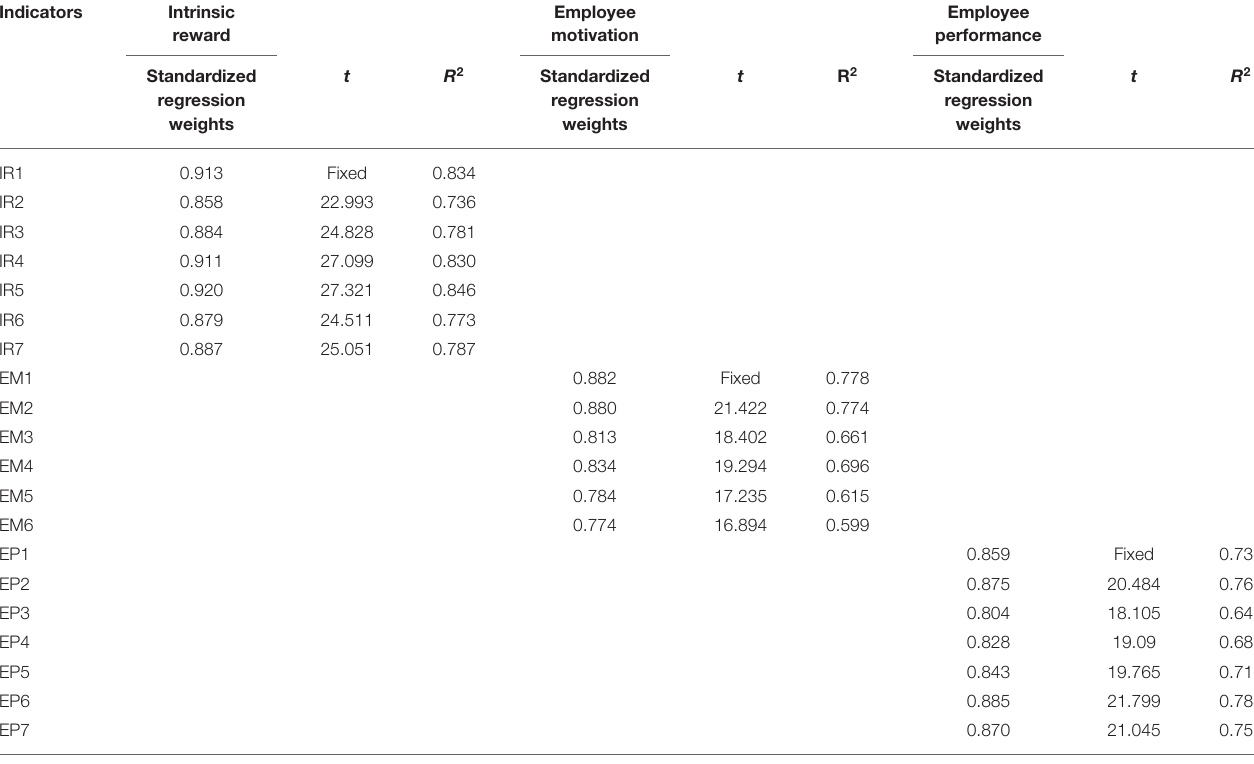
TABLE 4 | Measurement model for explanatory variable (intrinsic reward), dependent variable (employee performance), and mediator variable (employee motivation). Indicators